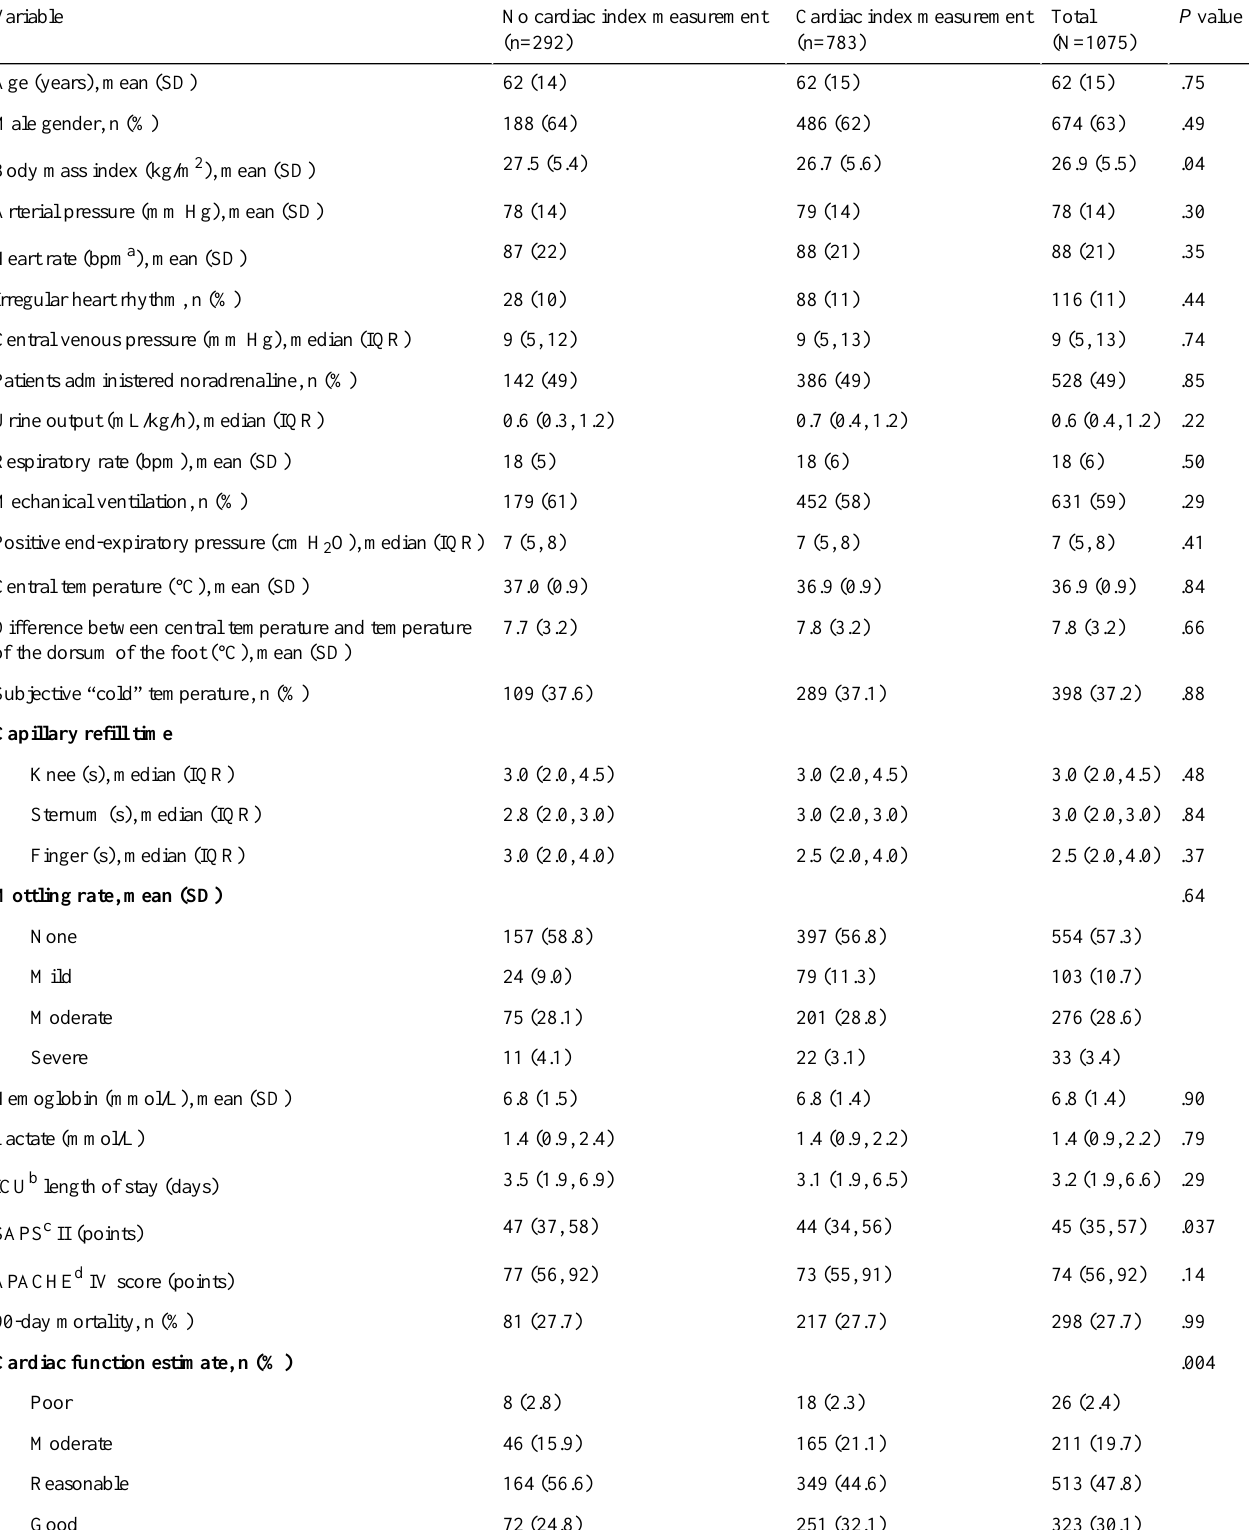
Table 1. Patient